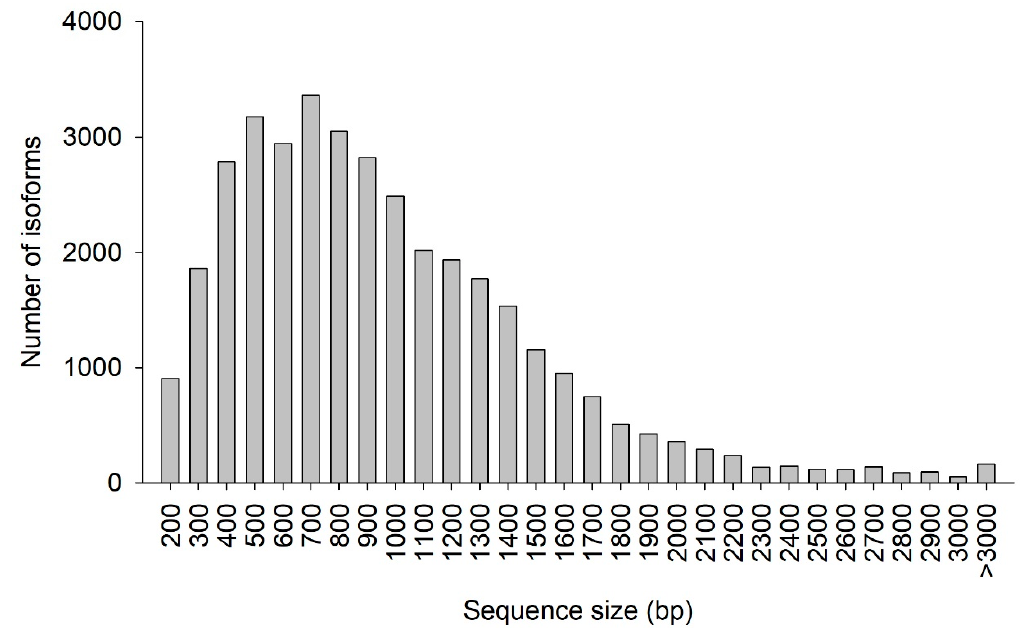
Figure 6. Coding DNA sequence (CDS) length distribution. The x-axis represents the length of CDS. The y-axis represents the number of CDS.